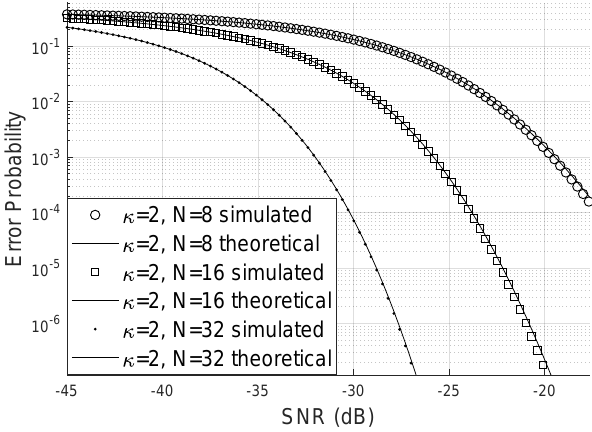
Figure 7. Error probability for Von Mises distributed phase